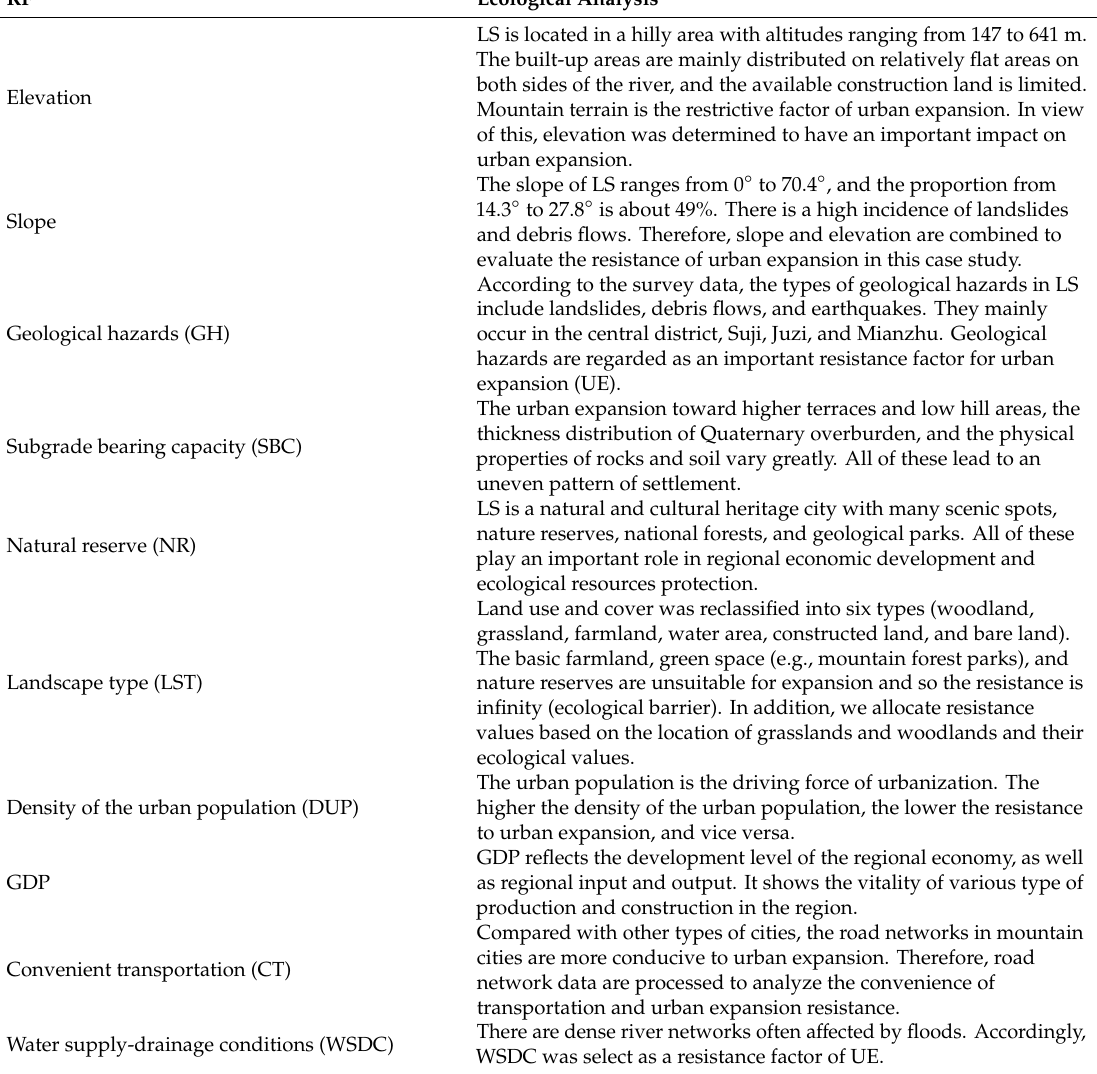
Table 1. Selected resistance factors and their ecological analysis (RF represents the resistance